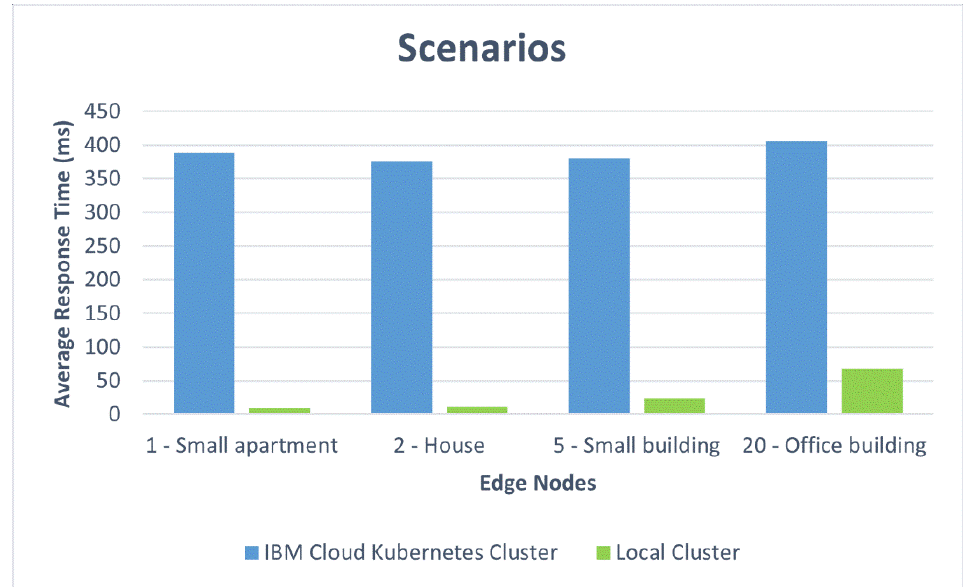
Figure 12. Comparative response times for different scenarios.